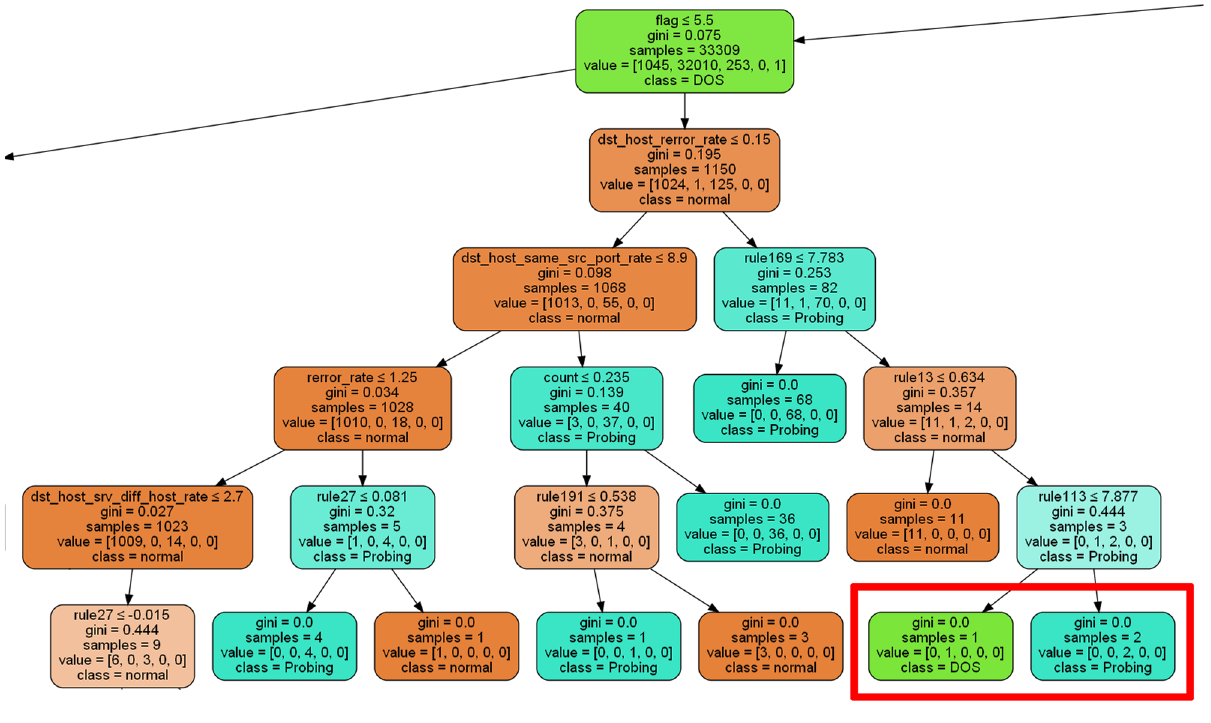
Figure 6. The node for interpreting the pattern.